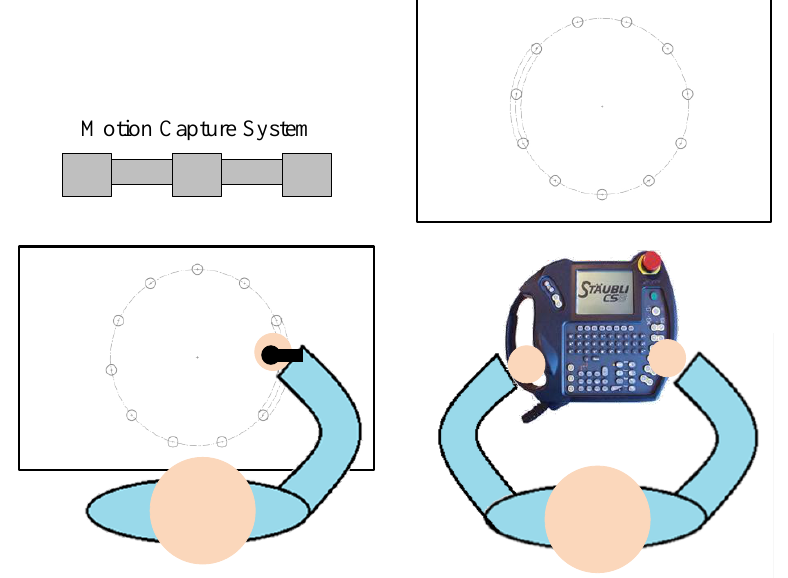
Figure 5. Participants sat or stood at the experiment platform, using (a) the teach pen or (b) the teach